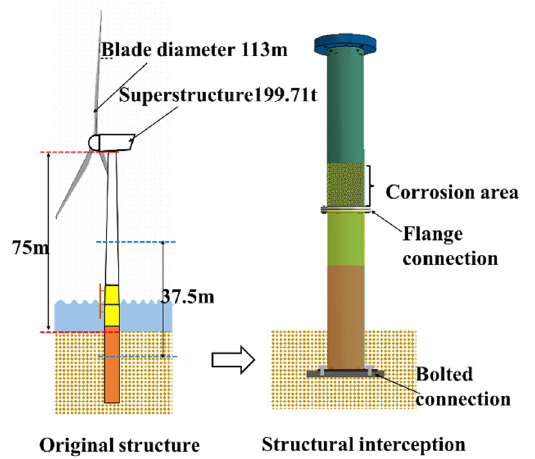
Figure 22. Selection of shaking table test model. Table 7. Similarity ratio of experimental model.